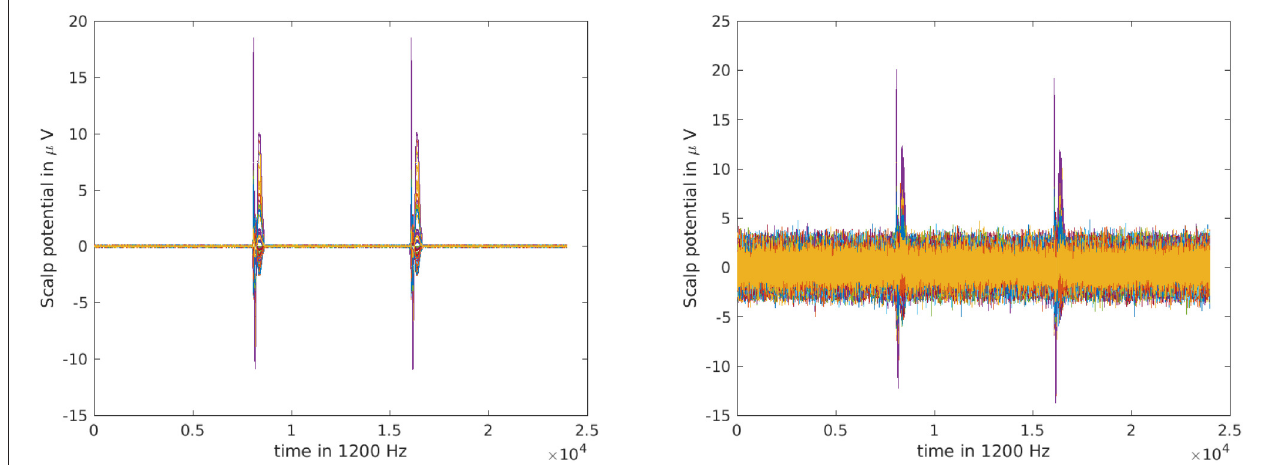
FIGURE 4 | Simulated EEG measurement of one source point with low noise (left) and high noise (right) as butterfly